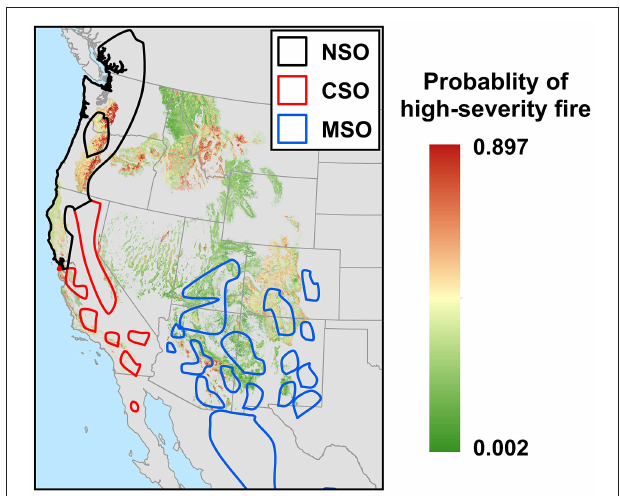
FIGURE 5 | Probability of high-severity fire across the western United States forests predicted by the Parks et al. (2018) models, which modeled the effects of fuel, topography, climate, and fire weather on high-severity fire probability. Ranges of the northern spotted owl (NSO), California spotted owl (CSO), and Mexican spotted owl (MSO) are indicated by black, red, and blue polygons, respectively. Area in gray indicates data were unavailable either due to area being non-forest, low model performance, or no available model (see Figure 1 ).